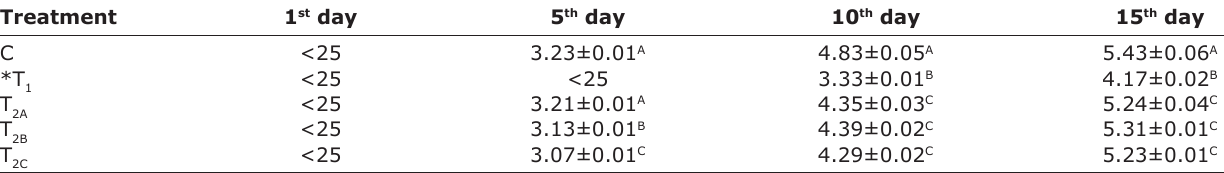
Table-5: Effect of CS and LS on TVPC (log CFU/g) of pork sausage at different storage periods (mean±SE). Treatment